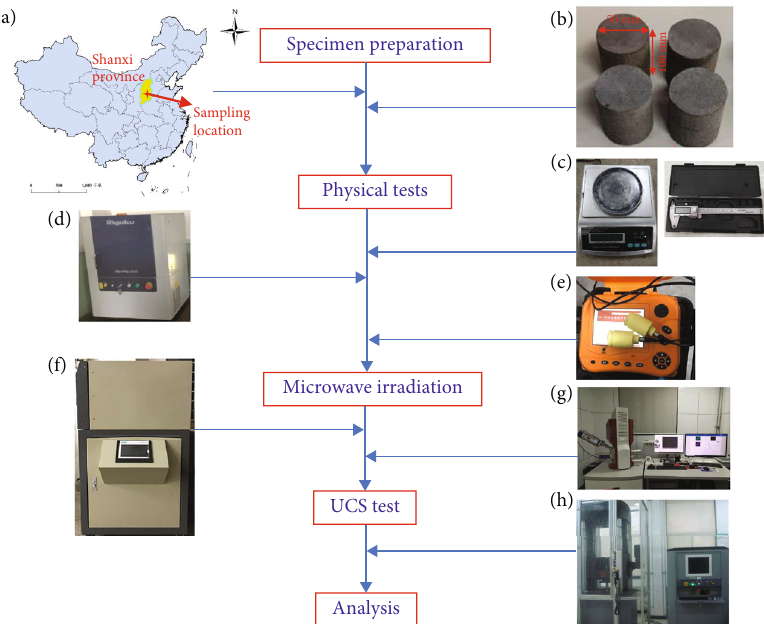
Figure 1: Experimental procedures and equipment: (a) sampling site, (b) parts of the cylindrical specimens, (c) mass and dimension measurement, (d) XRD devices, (e) ultrasonic wave instrument, (f) microwave treatment system, (g) SEM devices, and (h) UCS system.